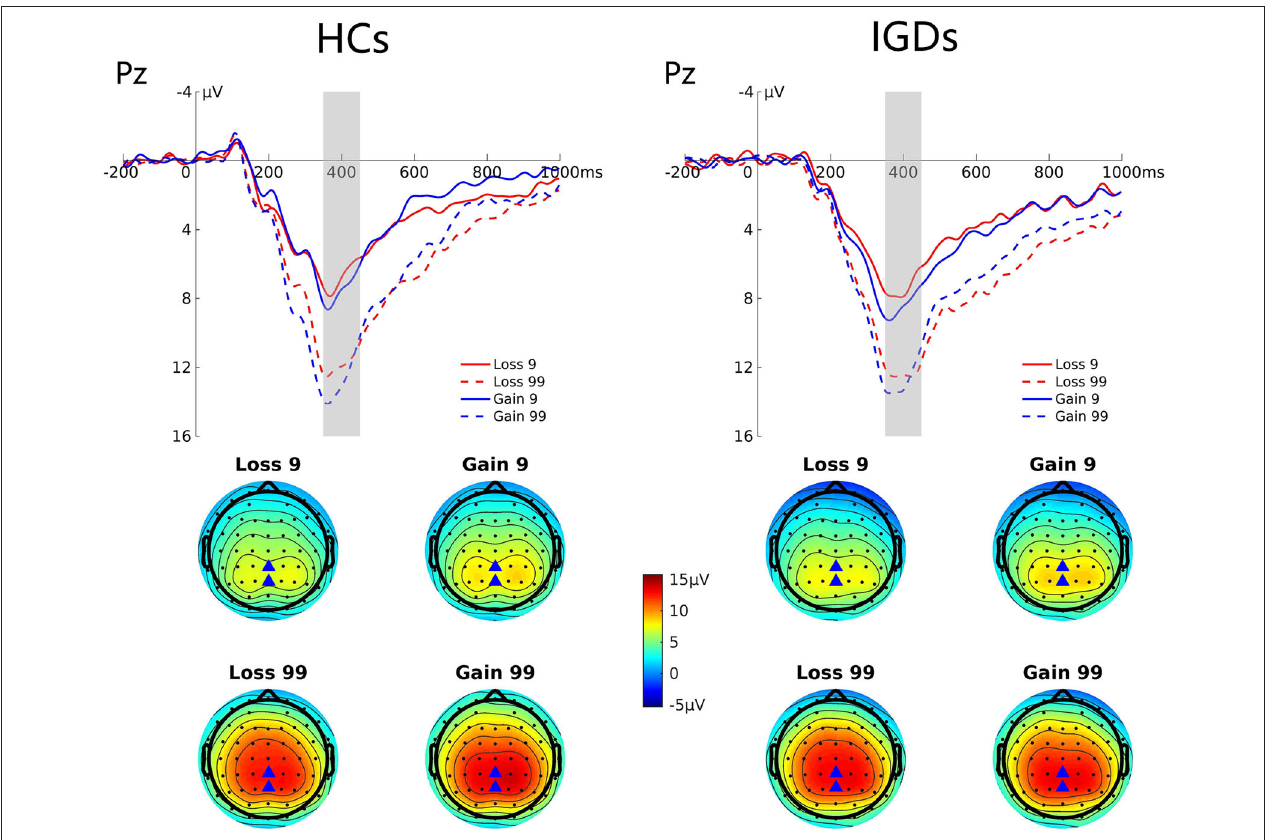
FIGURE 4 | Grand average ERP waveforms following low- and high-risk decisions for HCs and IGDs at Pz. The upper figure shows the ERP waveforms for controls and IGDs at Pz. The time window was depicted as the shaded areas. The lower figure shows the topographic maps on time window